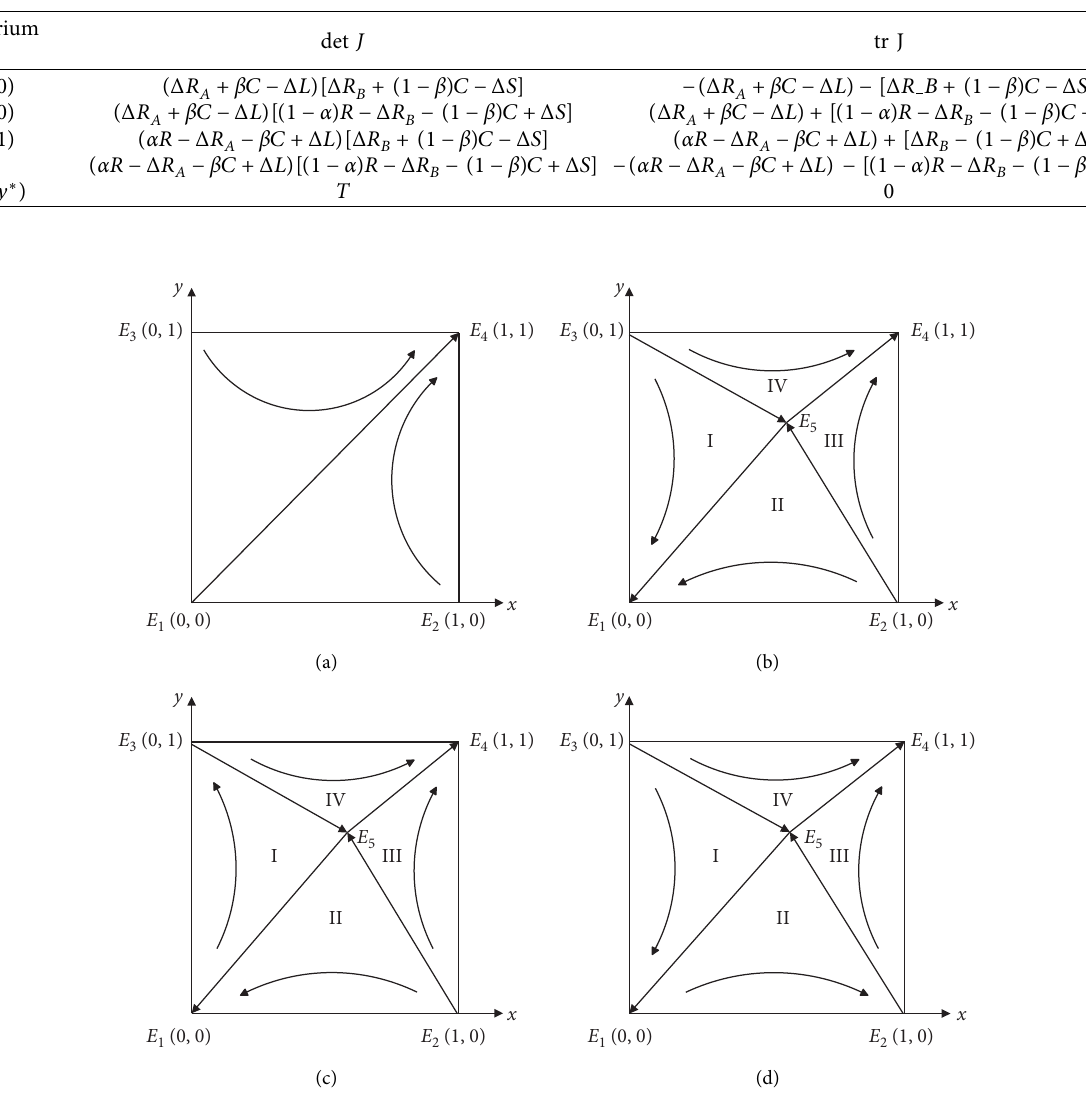
Figure 2: (a) The equilibrium result when both Δ S and Δ L are large; (b) the equilibrium result when both Δ S and Δ L are small; (c) the equilibrium result when Δ S is large and Δ L is small; (d) the equilibrium result when Δ S is small and Δ L is